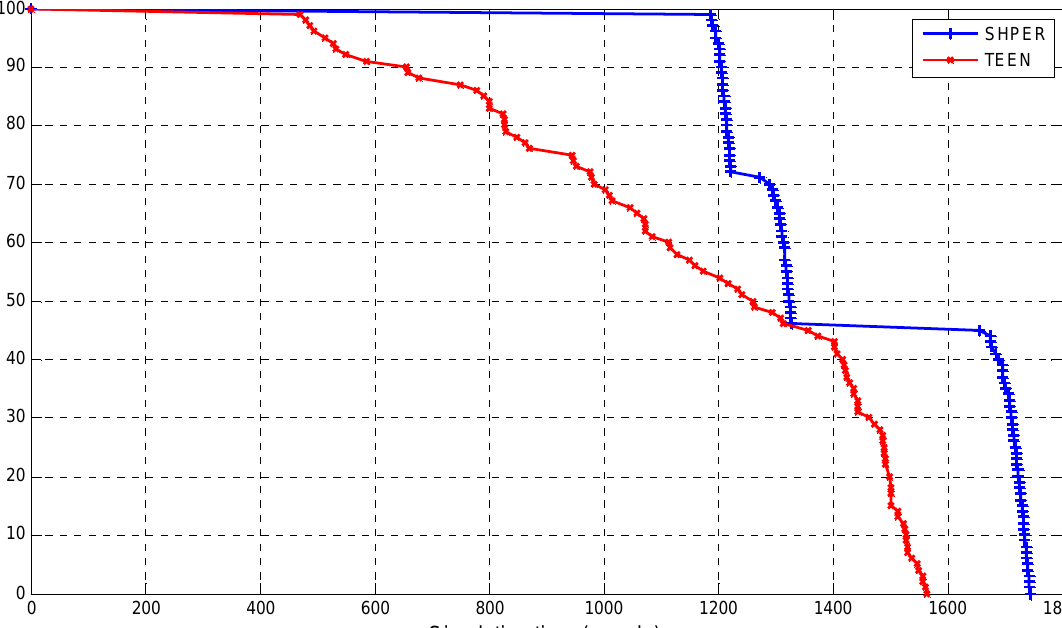
Figure 4. Comparative depiction of the nodes remaining alive over the simulation time steps in SHPER and TEEN [ Er (0) = 0.5 J, D = 100 i